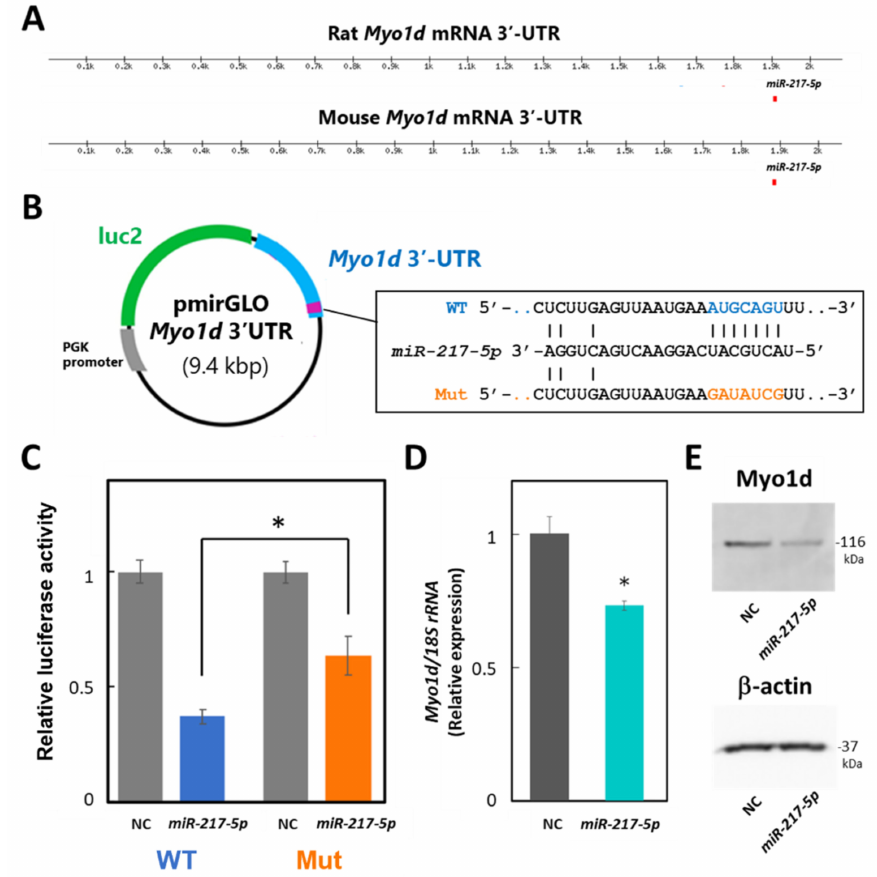
Figure 6. Target validation of miR-217-5p in PAN-treated rat podocytes. ( A ) Schematic illustration showing the putative position of miR-217-5p binding sites in the 3 (cid:48) -UTRs of mouse and rat Myo1d mRNAs predicted by TargetScan Human 8.0. ( B ) Schematic illustration showing the structure of the reporter plasmid with the wild-type (WT) and mutated (mut) 3 (cid:48) -UTR of mouse Myo1d . ( C ) A luciferase reporter assay examining targeting of the Myo1d 3 (cid:48) -UTR by rno-miR-217-5p . The relative light units (RLUs) of firefly luciferase activity under the control of the Myo1d 3 (cid:48) -UTR were normalized to those of constitutively controlled Renilla luciferase. The average relative RLUs of luciferase activity in the negative control miRNA mimic (NC)-transfected cells was set at 1. Data represent the means ± SD of triplicate measurements. * p < 0.05 versus control. ( D ) Expression levels of the Myo1d mRNA in E11 cells transfected with the miR-217-5p mimic or NC. Myo1d mRNA levels were analyzed using qRT-PCR, and the data were normalized to the expression level of 18S rRNA. The average normalized Myo1d mRNA expression level in NC-transfected cells was set at 1. ( E ) Expression levels of the Myo1d protein in E11 cells transfected with the miR-217-5p mimic or NC. Myo1d protein expression was analyzed using Western blotting. The expression of β -actin protein as an internal control was analyzed on the same blot. The original images of blots from two independent experiments are shown in Figure